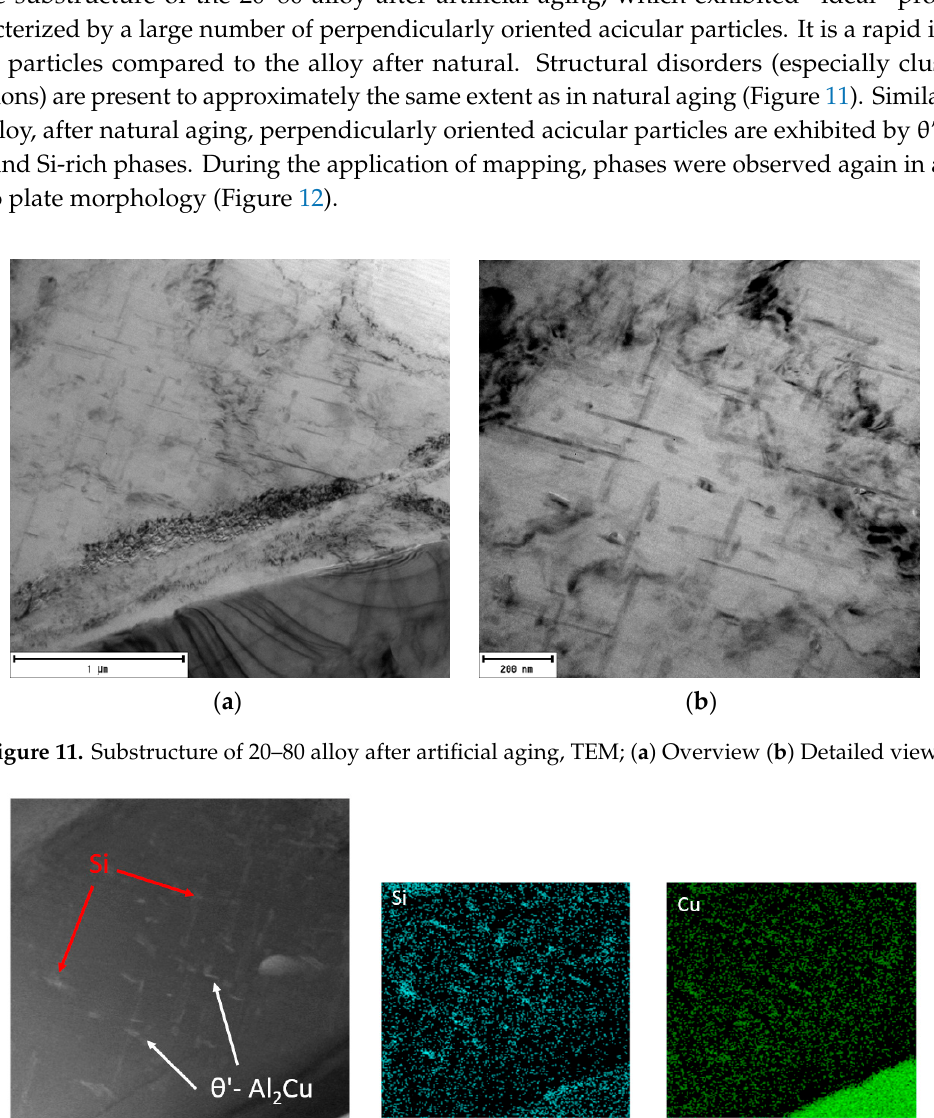
Figure 10. Point EDX analysis of 20–80 alloy substructure after natural aging; ( a ) Places of point EDX analysis, ( b ) Results of chemical composition of structural components.